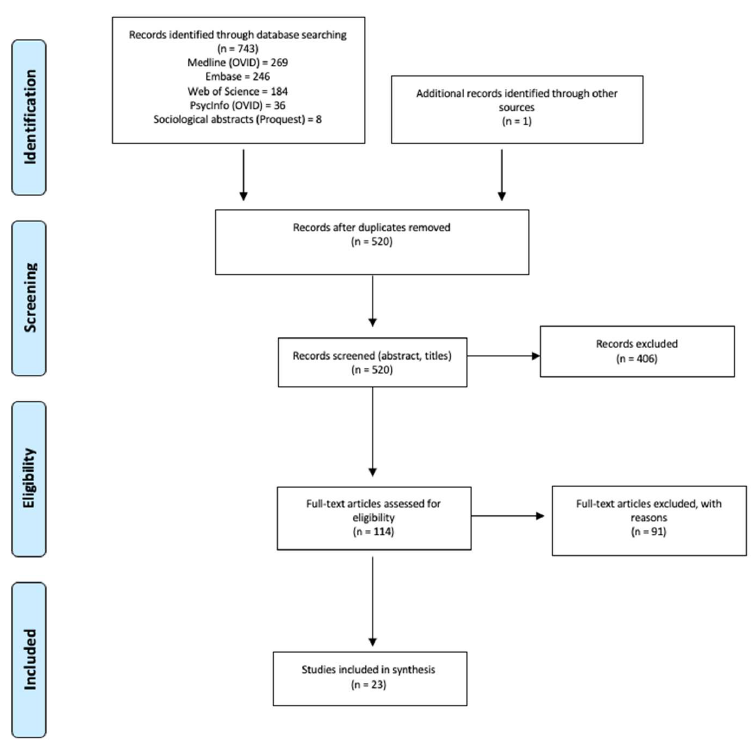
Figure 1. PRISMA Flow Diagram.